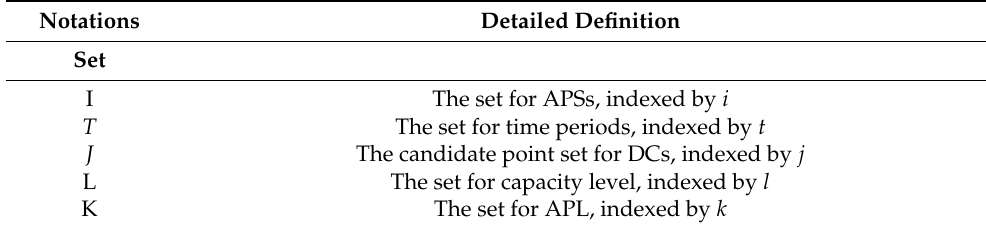
Table 2. Variables and parameters used in the LIRP.